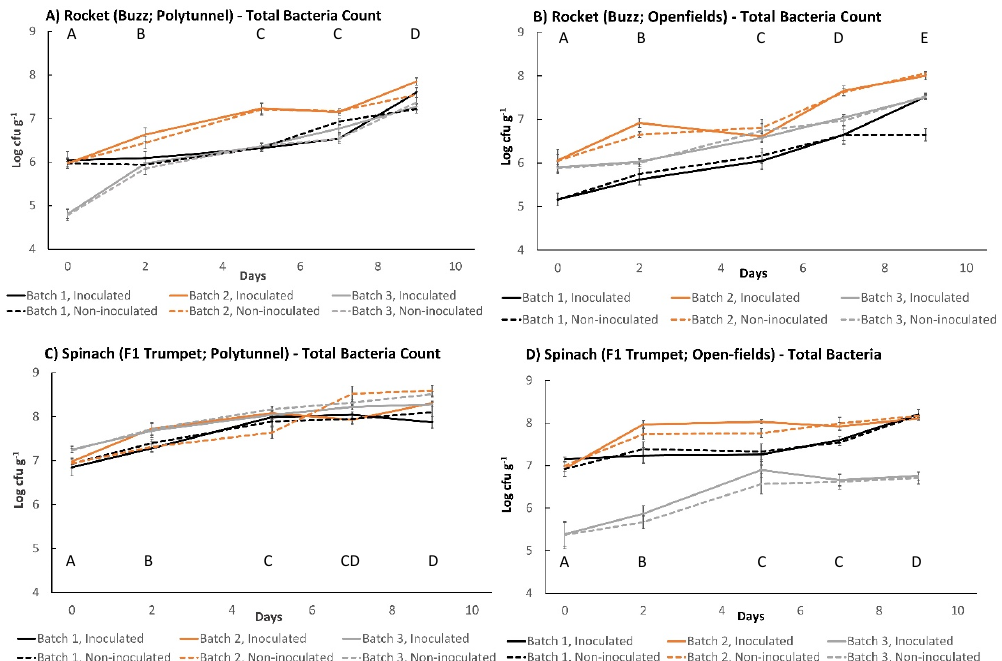
Figure 4. TBCs of experimental farm produce: ( A ) polytunnel rocket (Buzz), ( B ) open field rocket (Buzz), ( C ) polytunnel spinach (F1 Trumpet), and ( D ) open field spinach (F1 Trumpet). Incubated at 7 °C for (6 days) followed by 12 °C (3 days). (±) error bars indicate standard deviation. Solid lines represent produce which has been initially inoculated with 100 cfu g - 1 of L. monocytogenes ; dashed lines represent test units which have not been initially inoculated; letters A–D indicate significant difference over time in batches inoculated with L. monocytogenes .